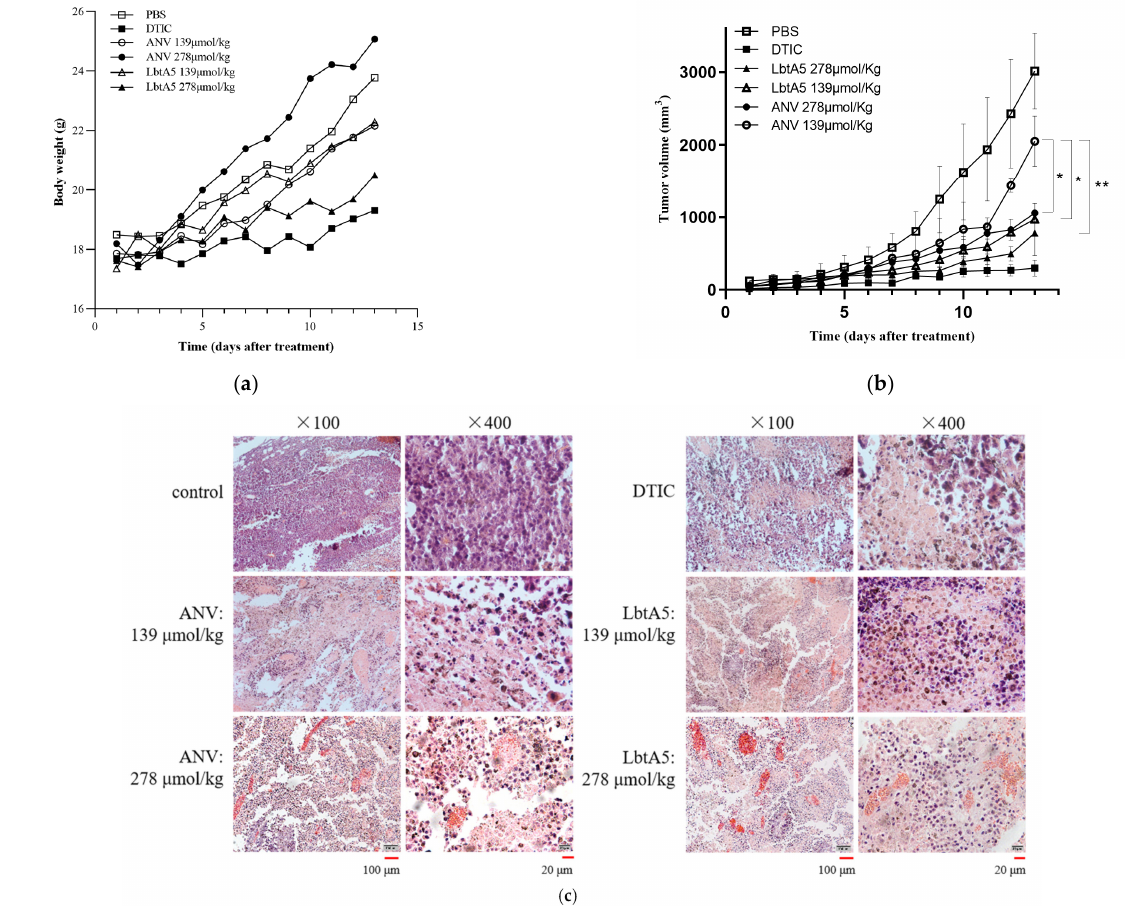
Figure 5. The antitumor effects of ANV and LbtA5 in mice bearing B16F10 melanomas. ( a ) Body weights of mice bearing B16F10 melanomas. Statistical analysis using the mean ± SD, n = 5; ( b ) Tumor volume comparison among different groups, * p < 0.05, ** p < 0.01; ( c ) Comparative histological analysis of tumor necrosis between different groups by H&E staining. After 13 days of continuous treatment, the mice were sacrificed, the tumor tissues were removed and prepared for sectioning, and H&E staining was performed and observed and photographed with an inverted microscope. The tumor tissues of the mice in the PBS group were the negative control group, and the DTIC group was the positive control group. The left side of each group was photographed at 100 × , and the right side was photographed at 400 × magnification of a local area in the same